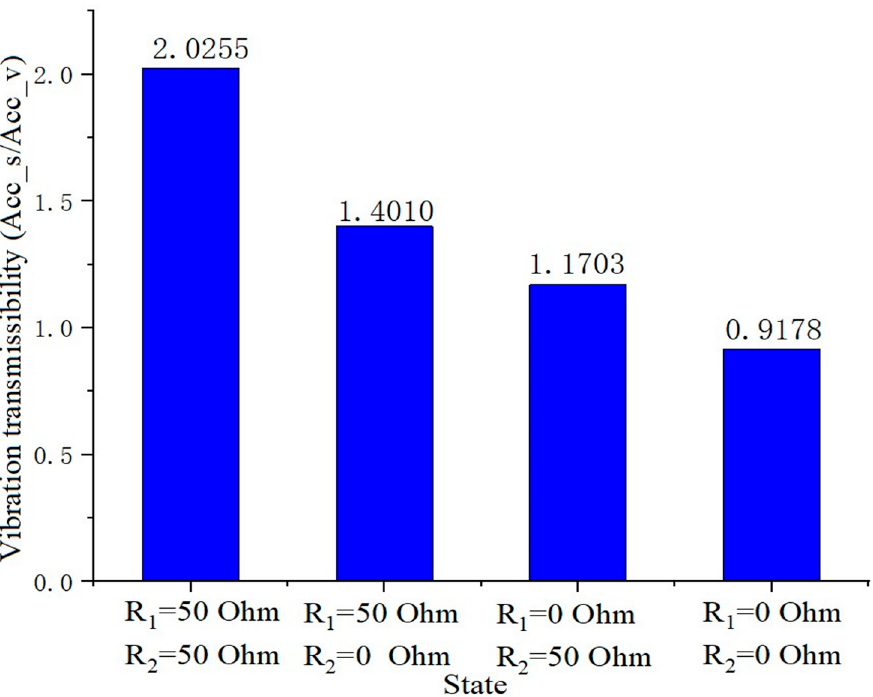
Figure 13. Acceleration transmissibility of suspension.